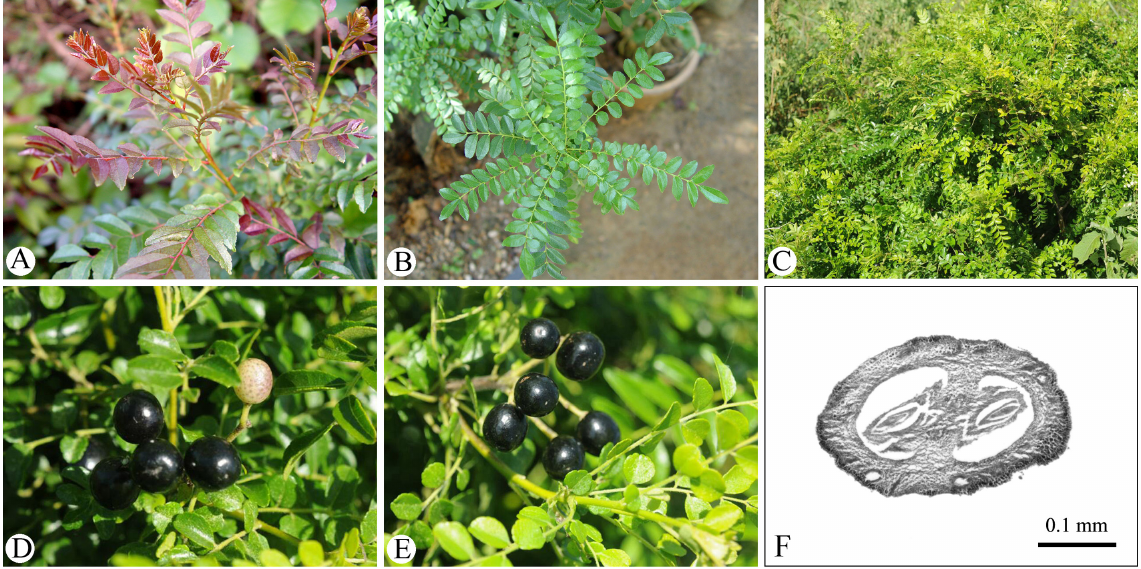
Fig. 10. Bergera microphylla (Merr. & Chun) F.J.Mou comb. nov. A–C . Plants. D–E . Infructescence. F . Ovary crossection. Photos taken by Feng-Juan Mou and Dan Liang in